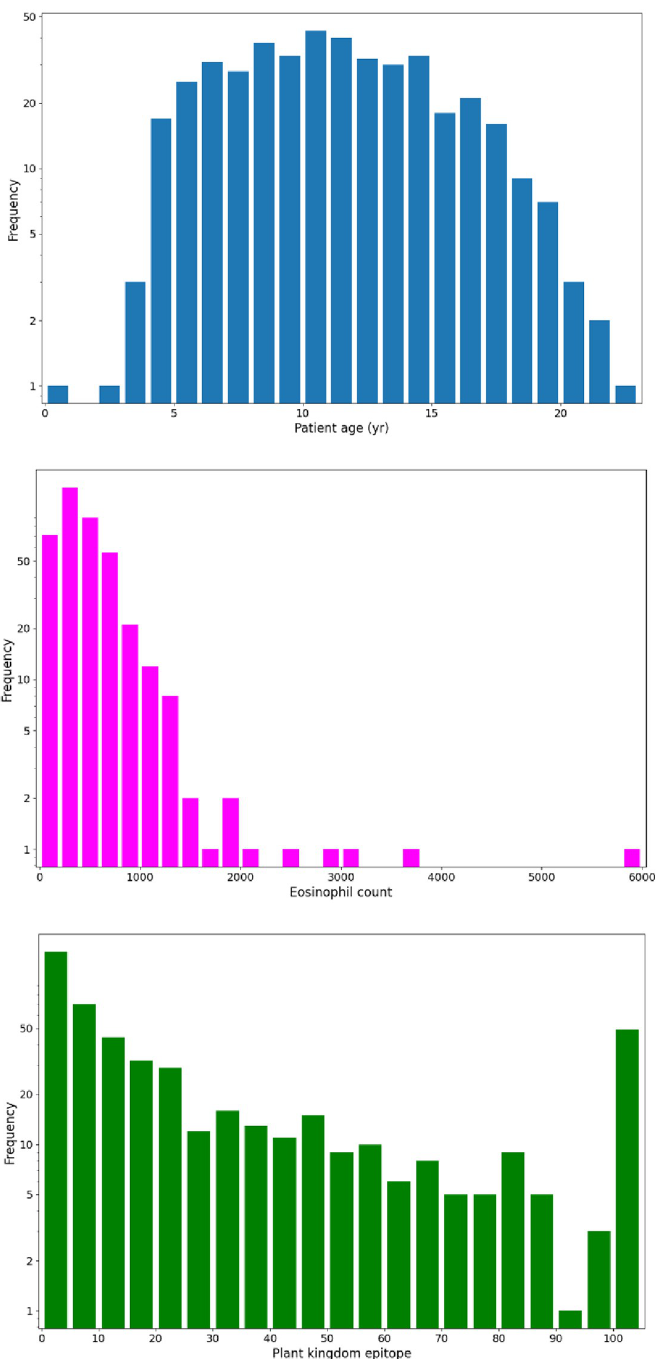
Fig 2. Distribution of values for some independent data